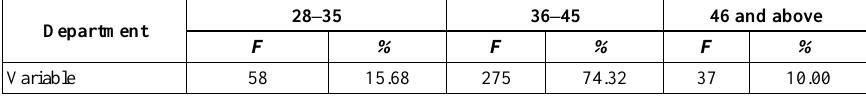
Table 4. Distribution of academicians by